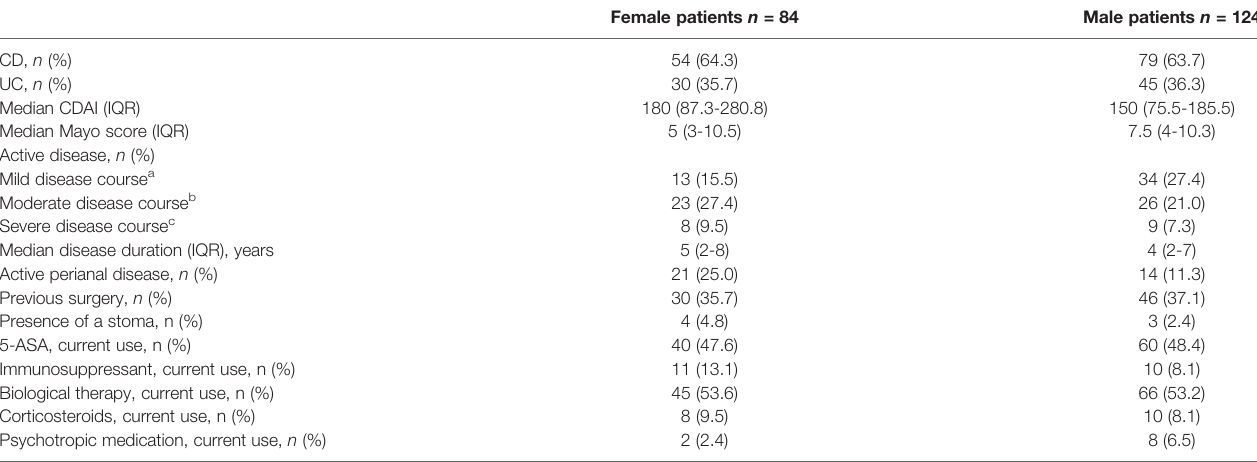
TABLE 2 | Characteristics of the IBD population.